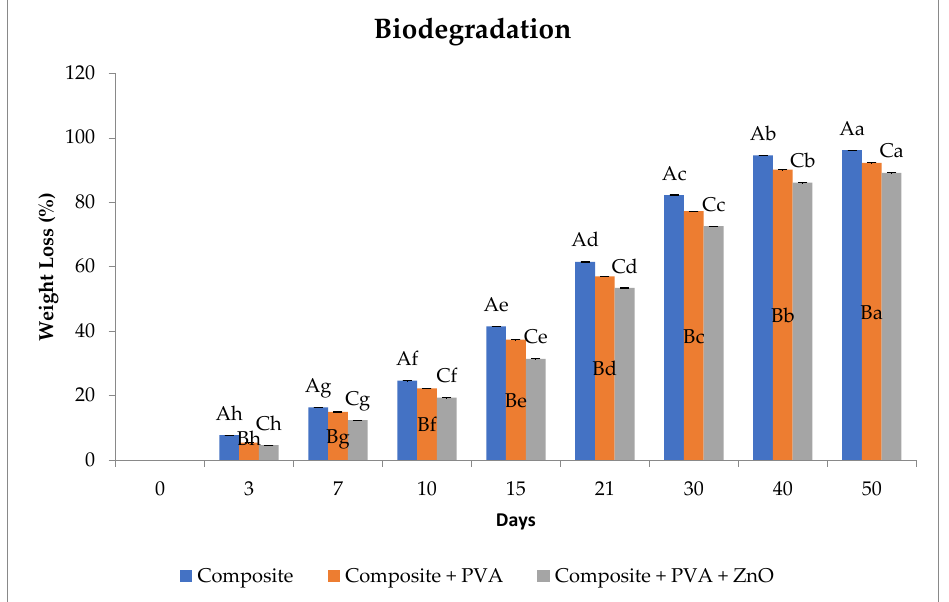
Figure 6. Biodegradation of different types of films. Figure representing the values (Mean ± S.E). A – C superscripts represent significant differences within samples on a particular day ( p < 0.05). a – h superscripts represent significant differences among different samples between days ( p < 0.05).